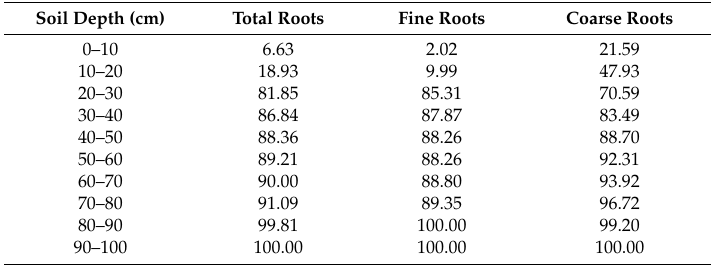
Table 5. Cumulative percentage of root biomass density in the soil profile (Unit: %).